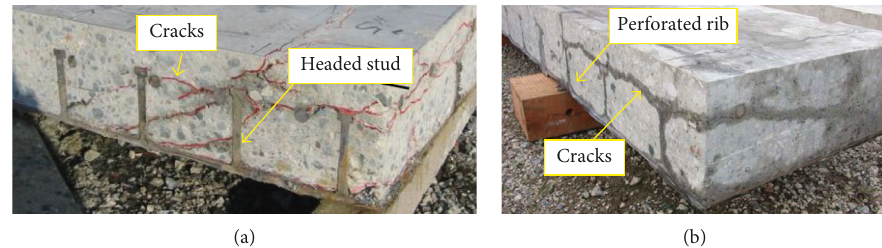
Figure 1: Premature cracks around the top of the shear connectors. (a) Headed stud [3]. (b) Perforated rib [9].